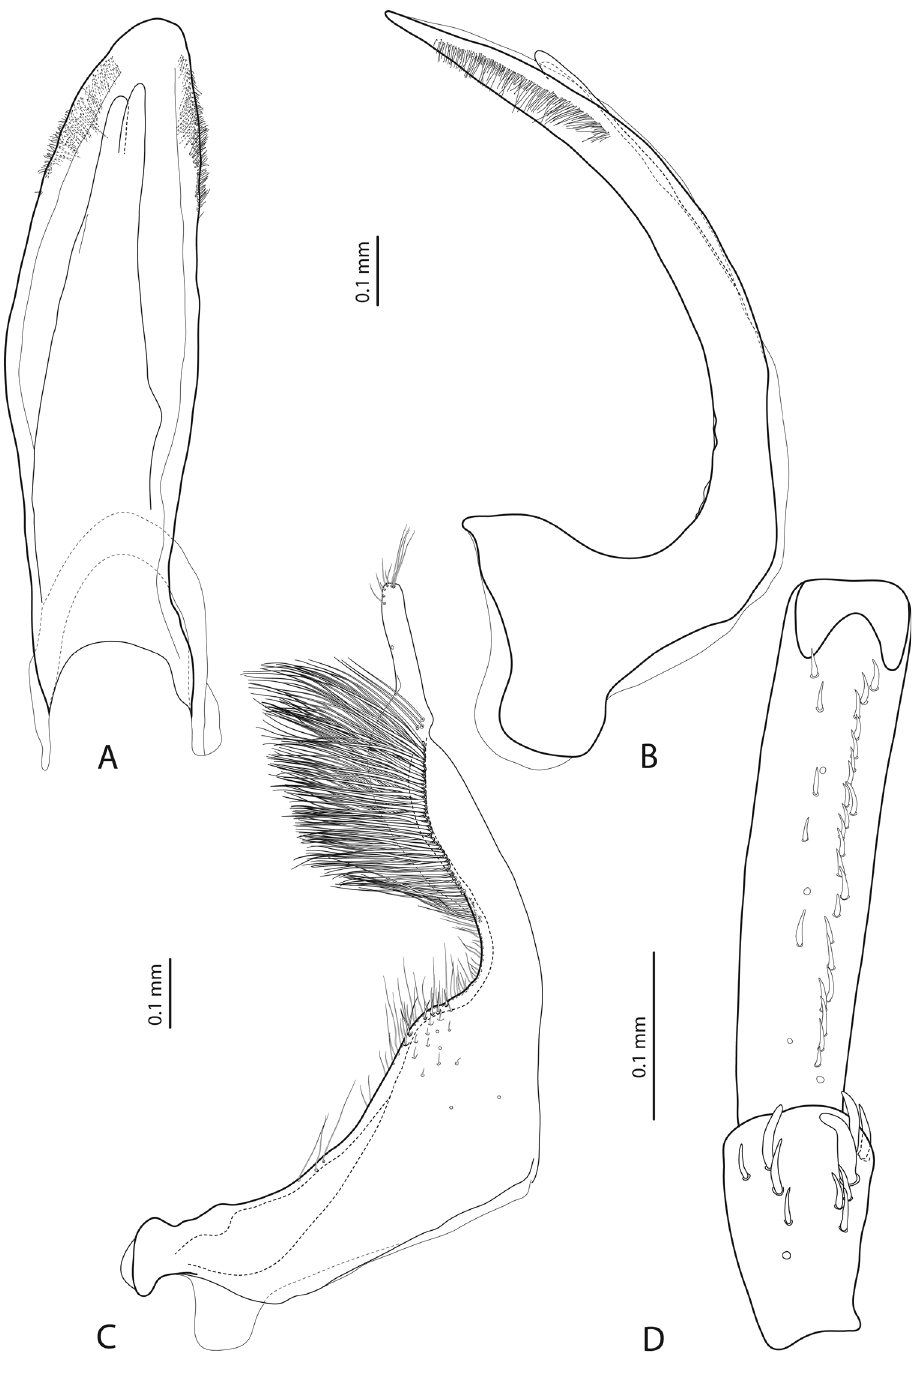
Figure 11. Exocelina ascendens (Balke, 1998) A median lobe in ventral view B median lobe in lateral view C paramere in external view D male protarsomeres 4–5 in ventral